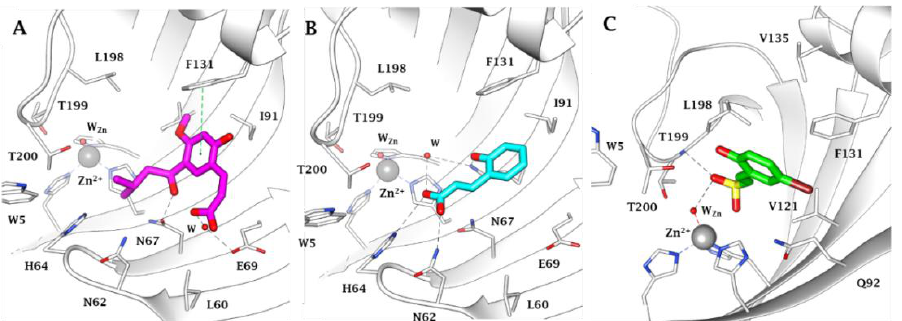
Figure 2. A ribbon view of the active site of hCA II in adduct with ( A ) Compound 4 (cyan, PDB 5BNL), derived from the CA-mediated hydrolysis of coumarin 1 ; ( B ) Compound 5 (magenta, PDB 3F8E), derived from the CA-mediated hydrolysis of coumarin 2 . ( C ) Compound 6 (green, PDB 4BCW), derived from the CA-mediated hydrolysis of sulfocoumarin 3 . The Zn(II) is shown as a grey sphere that is bound to the protein His ligands (labels not shown). Water molecules are represented as red spheres. H-bonds are represented as black dashed